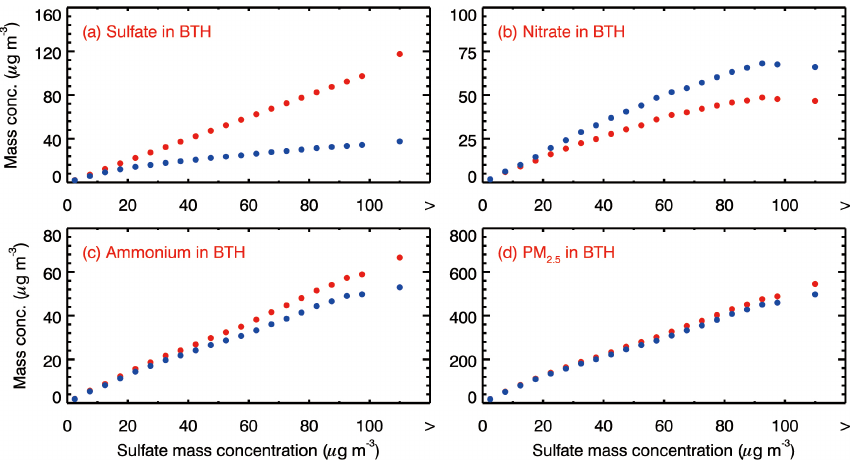
Figure 18. Same as Fig. 16, but in BTH from 13 to 21 January